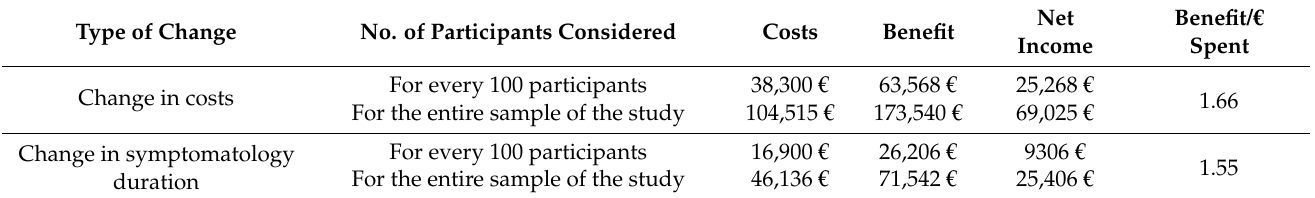
Table 7. Intervention sensitivity